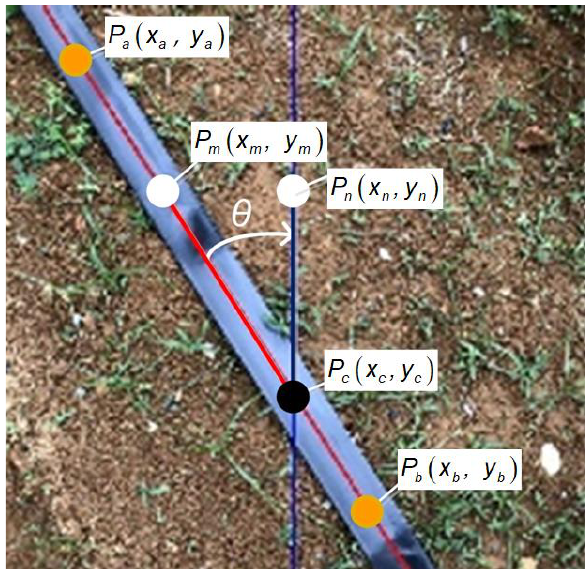
10 of 18 Figure 7. Line detection result when the robot turned: ( a ) Two frames within the snapshot that require image processing (solid frame and dashed frame); ( b ) The result of HSV transformation of the ROI in the solid frame (top) and the dashed frame (bottom) in the image (Figure 7a); ( c ) The V channel of the HSV image; ( d ) Binarization; ( e ) Median filtering; ( f ) Thinning; ( g ) Hough line transformation (red line) and the central vertical line (blue) of the image. 2.3. Determination of the Deviation Angle